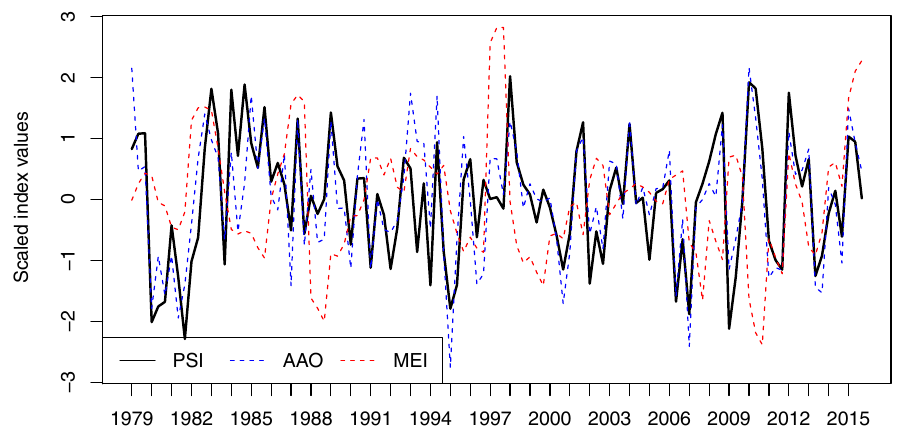
Figure 7. Time series of PSI (black solid line), NOAA’s AAO (blue dotted line), and NOAA’s Multivariate ENSO Index (MEI) (red dotted line) from 1979 to 2015.